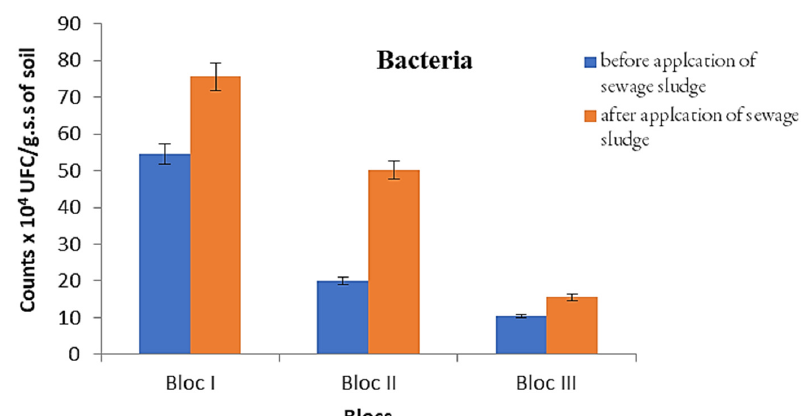
Figure 2. The average total bacterial count of the soil before and after application of Sewage sludge Total fungi count (TFC)